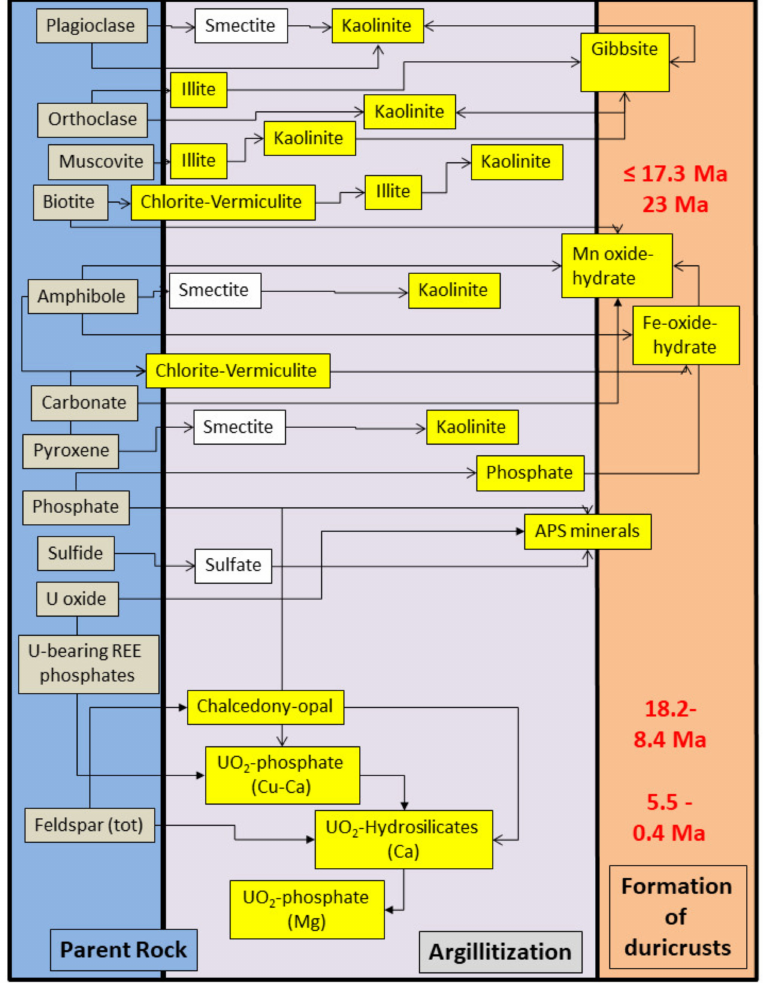
Figure 15. Parent rock and the binary subdivision of the supergene alteration